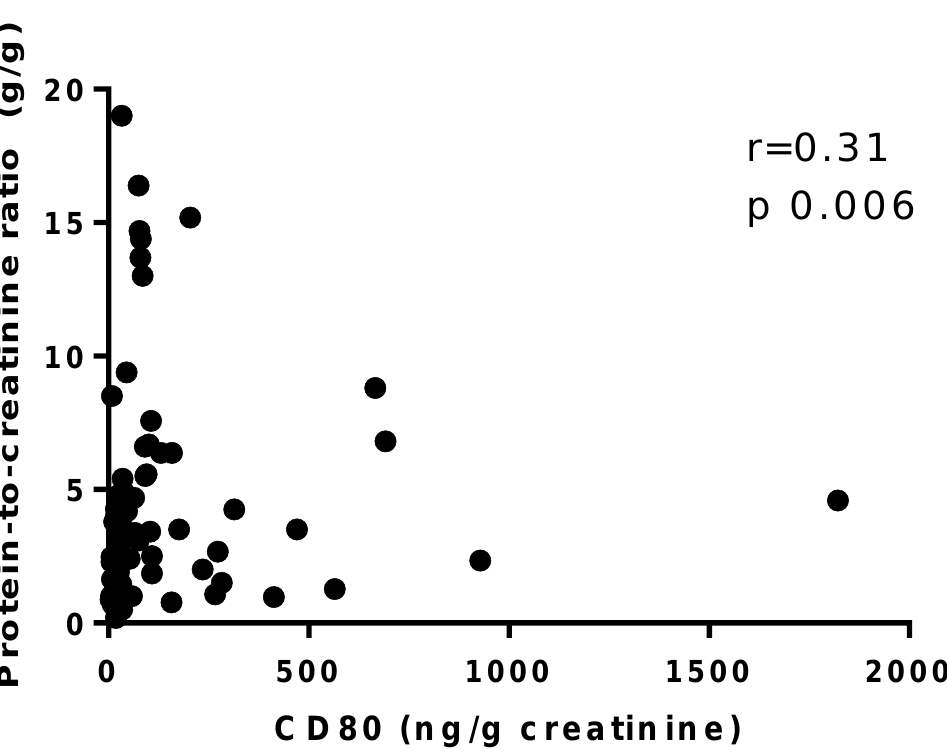
Figure 2. Correlation between urinary CD80 adjusted for urinary creatinine and baseline proteinuria. When the patients were divided into two groups by serum creatinine (<1.2 mg/dL and ≥ 1.2 mg/dL), the median (IQR) serum suPAR was found to be 3066 (2184–3409) pg/mL in the <1.2 mg/dL group and 4065 (2935–5405) pg/mL in the ≥ 1.2 mg/dL group, and